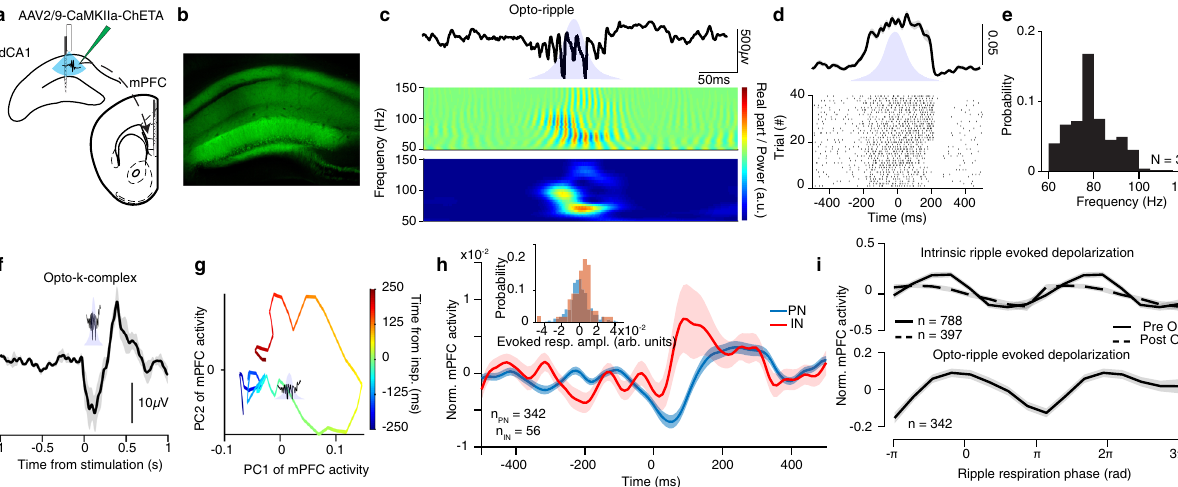
Fig. 9 Respiratory modulation of cortical excitability. a Schematic of the experimental design for testing the effect of optogenetically induced hippocampal ripples on the prefrontal network. An excitatory opsin (AAV2/9-CaMKIIa-ChETA) was injected in the dCA1 and a silicon probe paired with an optic fi ber was inserted to generate opto-rippled and to record the induced activity. Simultaneously, a silicon probe was implanted in the mPFC to record the effect of the intrinsic and optogenetically induced ripples. b Example histological reconstruction of the opsin expression in the dorsal hippocampus. c Example trace (top) and wavelet real part (middle) and power (bottom) of the oscillation generated in the dCA1 pyramidal layer during the optogenetic stimulation. Note the similarity with ripple oscillations. d Cross-correlation of fi ring with respect to optogenetic stimulation for one example dCA1 neuron and raster-plot for all events. e Probability distribution of the frequency of evoked oscillations during light stimulation ( N = 3 mice). f Example average evoked response in the mPFC LFP triggered on the opto-ripple generation in the dCA1. g Example trajectory of the mPFC population around the time of inspiration when an opto-ripple is generated during inspiration. h Evoked response in the mPFC neuronal population triggered on the opto-ripple generation in the dCA1. Inset, distribution of the evoked response amplitude for all cells ( n = 398 cells). i Z -score normalized prefrontal neuron evoked activity magnitude ( n = 788/397 cells) in response to intrinsic for pre and post-OD conditions (top) and optogenetically-generated ( n = 342 cells) (bottom) ripples, as a function of the respiratory phase of occurrence of the ripple. Shaded areas, mean ± SEM. arb. units arbitrary